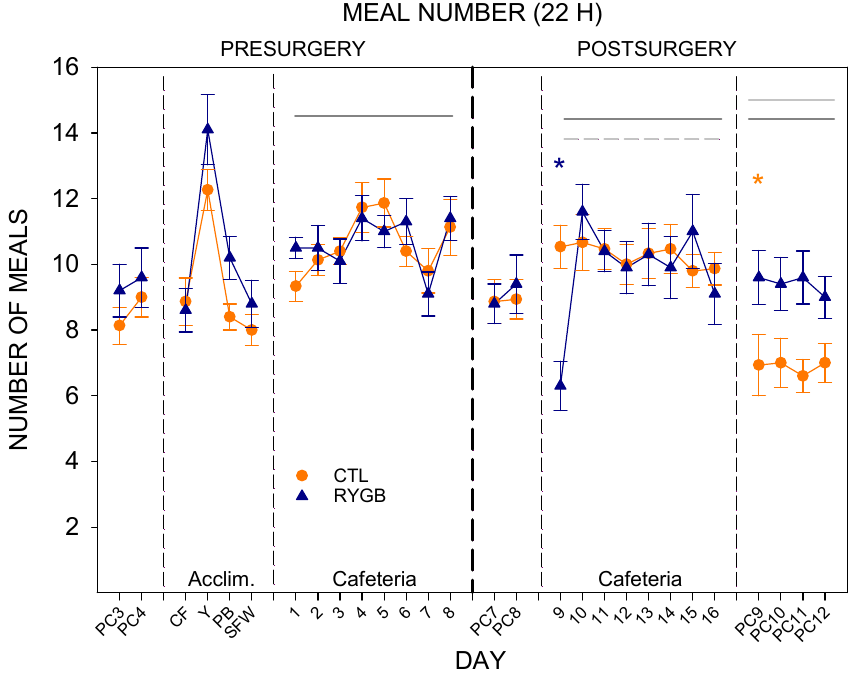
Figure 7. Meal Number across All 22-H Periods during Meal Pattern Monitoring. Mean (±SE) for CTL (combined SHAM and IRON groups, n = 14; orange circles) and RYGB ( n = 11; blue triangles) rats for powdered chow days (PC), acclimation days for each food (Acclim.; CF: chickpea flour; Y: yogurt; PB: peanut butter; SFW: sugar/fat whip), and cafeteria diet days. Dashed vertical lines indicate transitions between diet conditions (thin dashed) and between pre- and post-surgical phases (thick dashed). Statistically significant results from two-way mixed ANOVAs (Table 6) are indicated by horizontal lines: Gray solid (group), dark gray solid (day), or gray dashed (group × day interaction). *: Statistically significant result of a paired t -test (Table 7) for the group indicated by color, comparing the marked day to the previous day. Table 7. Paired t-tests Comparing 22-H Meal Number within Groups across Diets. PRESURGERY vs. POSTSURGERY Table 6. Two-way ANOVAs Comparing 22-H Meal Number between Groups for Each Diet Condition. PRESURGERY GROUP Powdered Chow Days